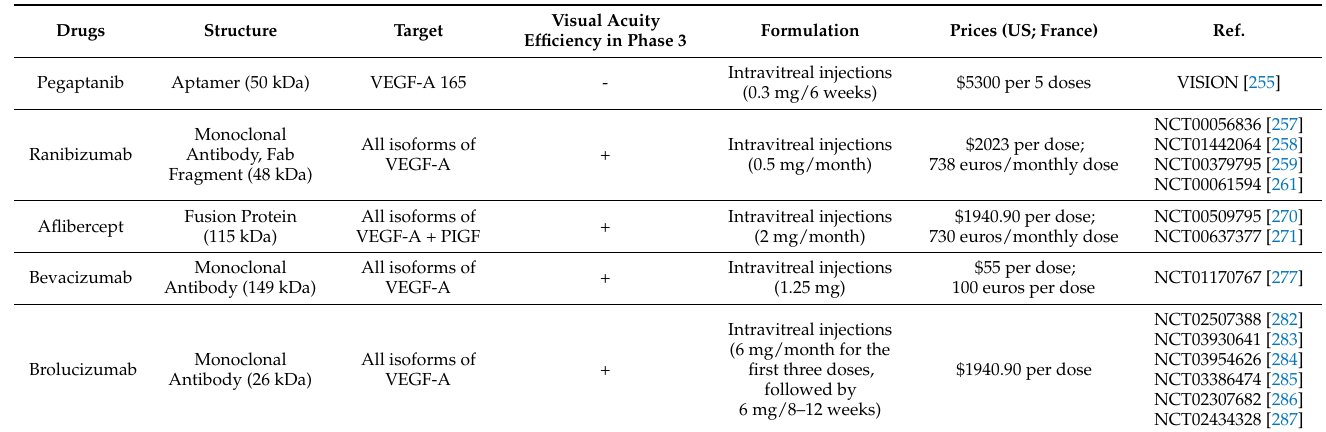
Table 9. Marked anti-VEGF